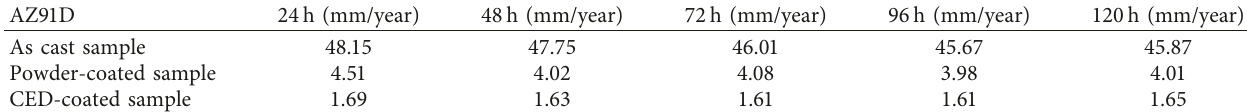
Table 10: Corrosion rate of samples after 24, 48, 72, 96, and 120 hours.